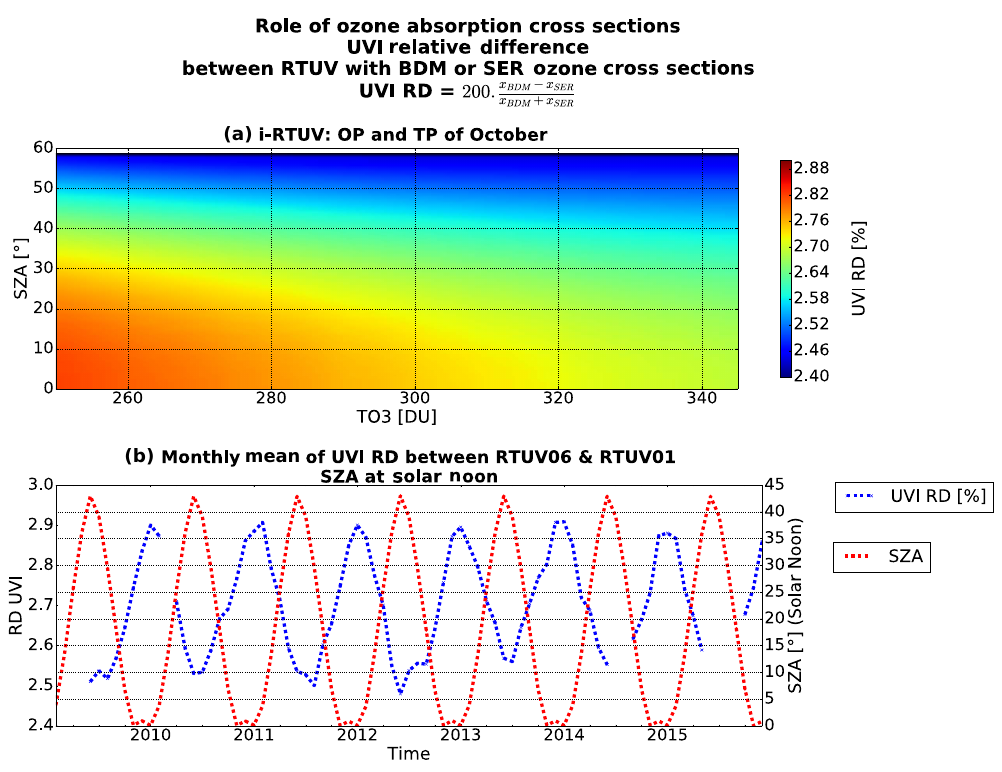
Figure 5. (a) UVI relative difference between two idealised runs with different O3XS for a varying TO 3 and SZA and for climatological OP and TP of October. (b) Monthly mean of UVI RD between RTUV06 and RTUV01 (blue dashed line). Monthly mean of SZA at solar noon (red dashed